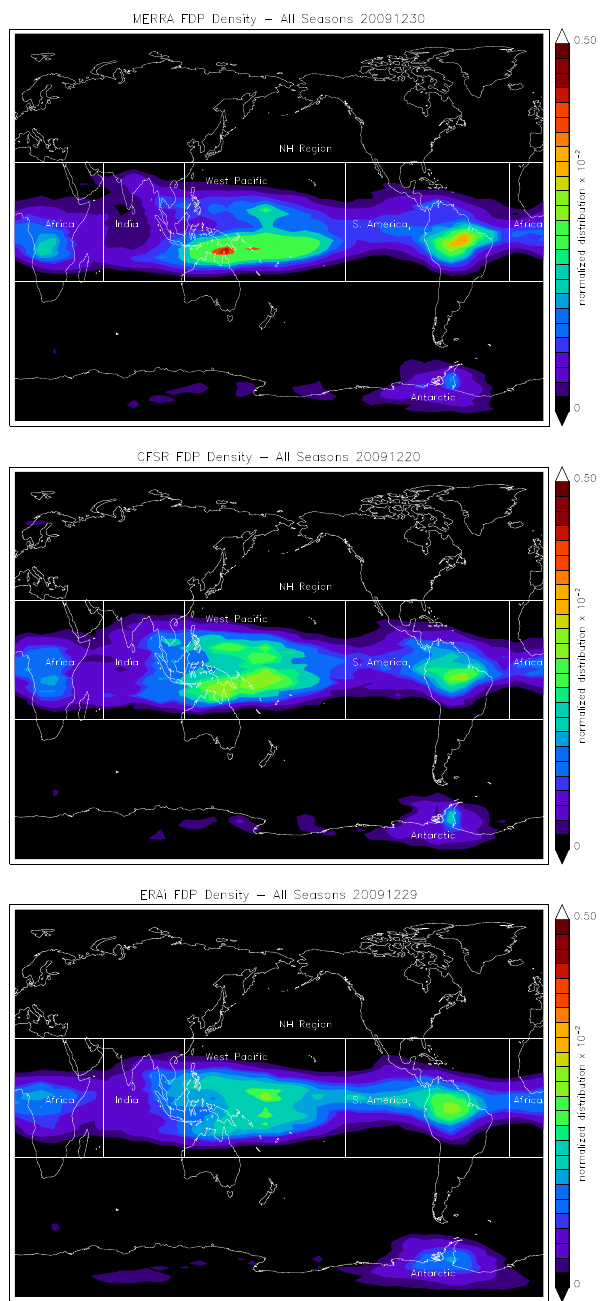
Fig. 3. Density of final dehydration locations from the three reanal- yses, (a) MERRA, (b) CFSR, and (c) ERAi.